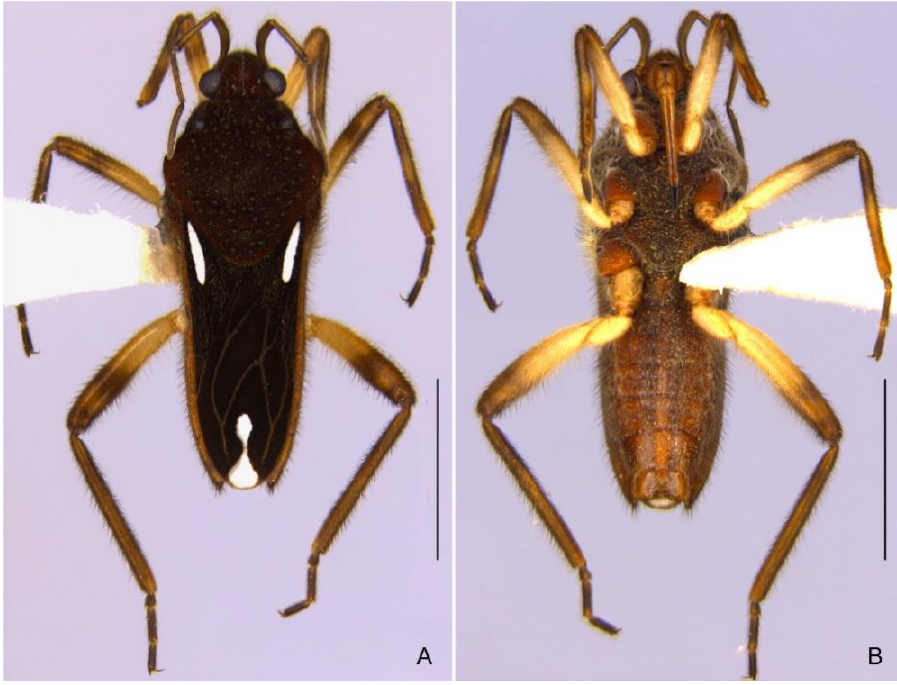
Figure 6. Paravelia bilobata , macropterous male from Aiuaba, Ceará state. ( A ). Dorsal view. ( B ). Ventral